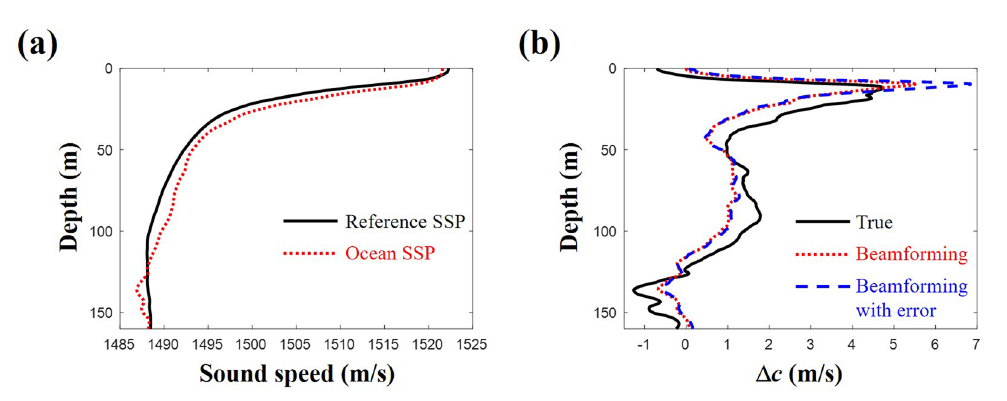
Figure 16. ( a ) one sound speed profile case in SWellEx-96, which has the largest deviation from the mean SSP; ( b ) sound speed differences along depth from the reference sound speed profile estimated with compressive sound speed profile inversion using beamforming results. The sound speed profile (dotted line) is reconstructed in the situation, where inevitable deviations from actual arrival angles and travel times exist owing to plane-wave approximation in beamforming. Random errors between − 2 ◦ and + 2 ◦ are added to direction of arrivals from the beamforming to account for the uncertainties in experimental environments (dashed